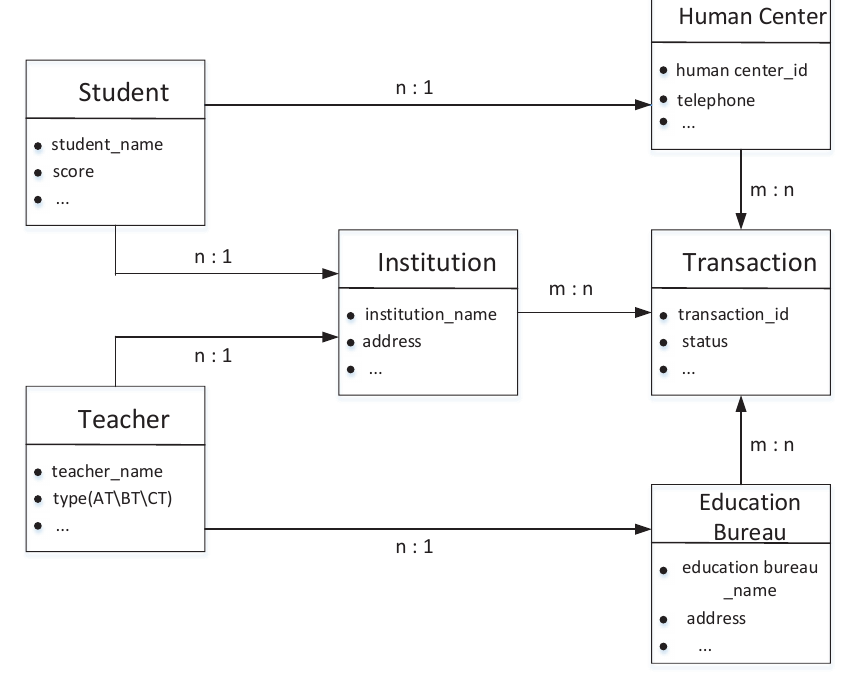
Figure 6. Ledger Structure